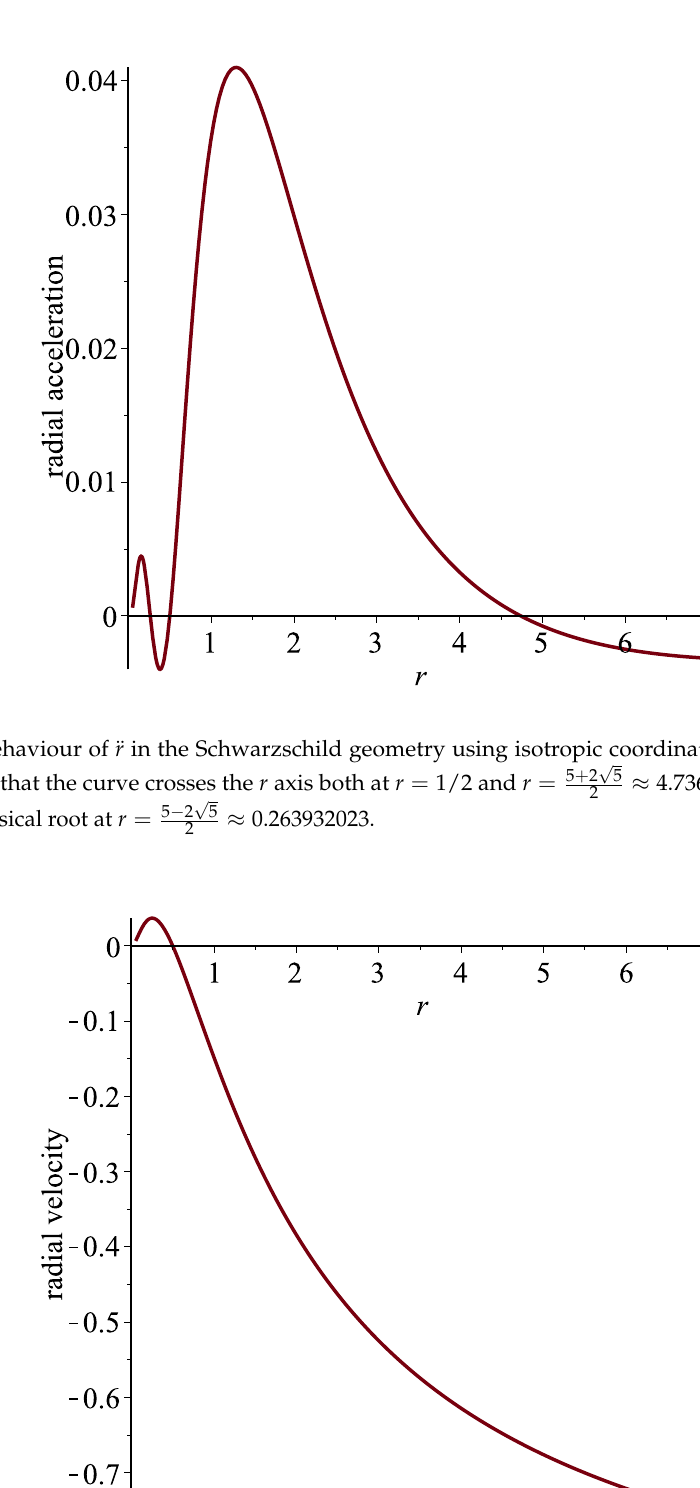
Figure 7. Behaviour of ˙ r for null geodesics in the Schwarzschild geometry using isotropic coordinates for m = 1 and (cid:101) → ∞ . Note the coordinate velocity is negative all the way from the horizon (now at m /2) to spatial